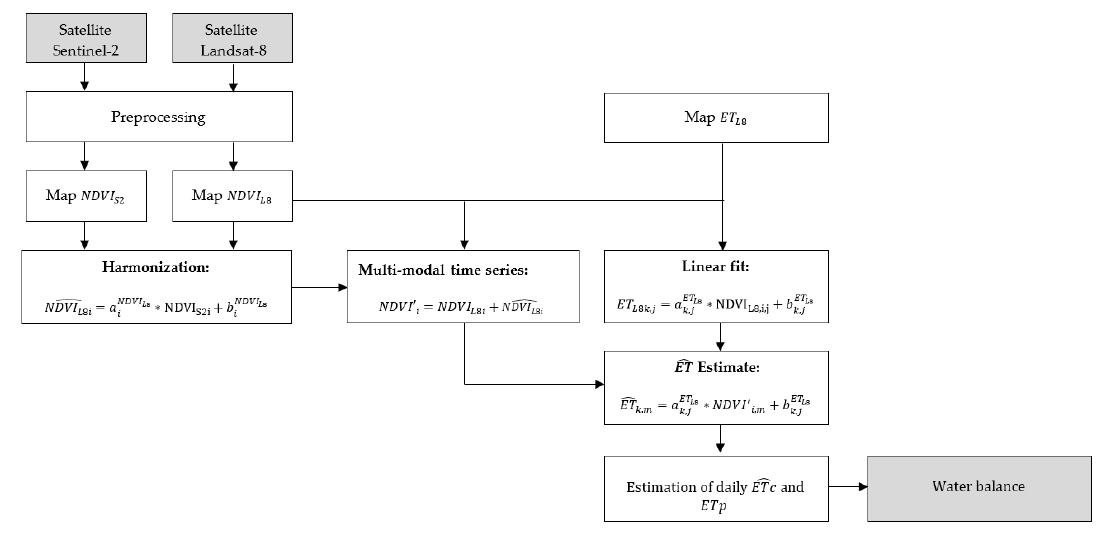
Figure 3. Overall diagram of the proposed